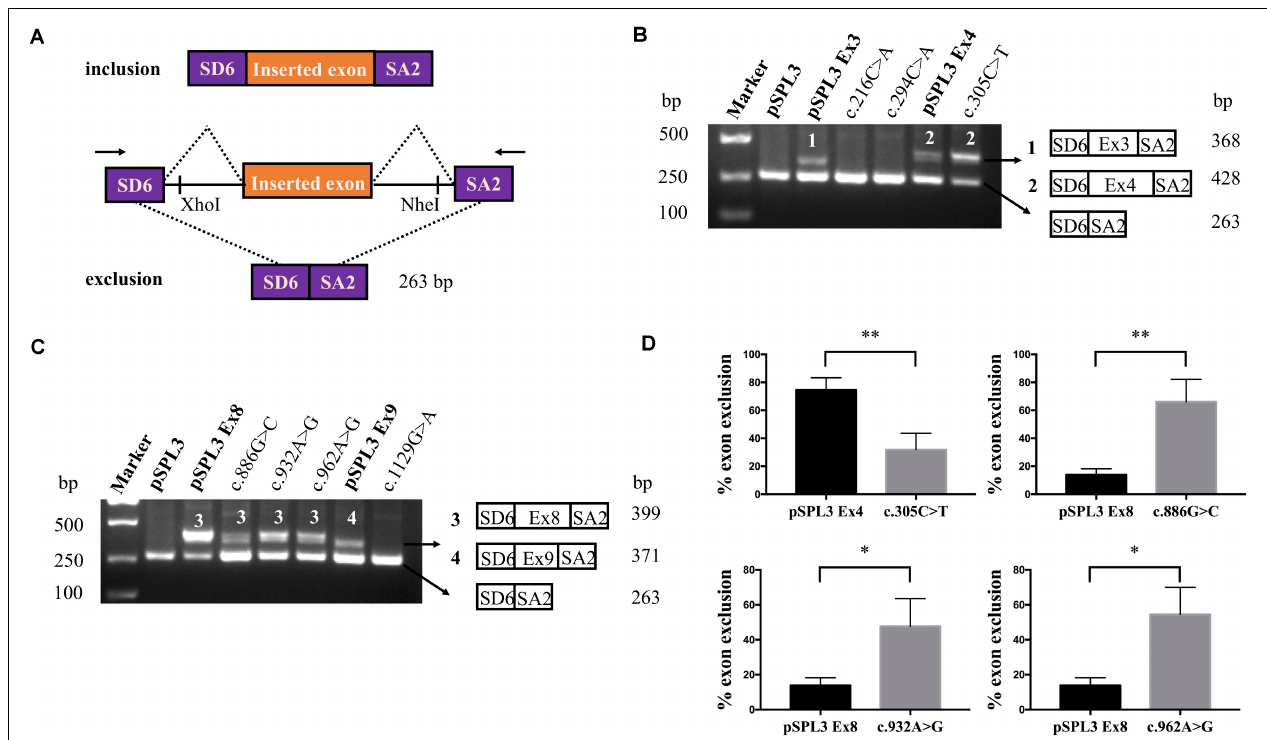
FIGURE 2 | RT-PCR results and DNA sequencing of SLC5A2 exonic variants. (A) RT-PCR amplified products of hybrid minigene transcripts in HEK293T cells. The transcripts produced by the hybrid minigene are schematically shown and the arrows show the primers used to amplify (inset). (B,C) Gel electrophoresis of the RT-PCR product of minigene transcripts in HEK293T cells. (B) Lane 1: marker; Lane 2: pSPL3 (263 bp); Lane 3: pSPL3 Ex3 (368 bp and 263 bp); Lane 4: c.216C > A (263 bp); Lane 5: c.294C > A (263 bp); Lane 6: pSPL3 Ex4 (428 bp and 263 bp); Lane 7: c.305C > T (428 bp and 263 bp). (C) Lane 1: marker; Lane 2: pSPL3 (263 bp); Lane 3: pSPL3 Ex8 (399 bp and 263 bp); Lane 4: c.886G > C (399 bp and 263 bp); Lane 5: c.932A > G (399 bp and 263 bp); Lane 6: c.962A > G (399 bp and 263 bp); Lane 7: pSPL3 Ex9 (371 bp and 263 bp); Lane 8: c.1129G > A (263 bp). All assays were performed in triplicate. (D)